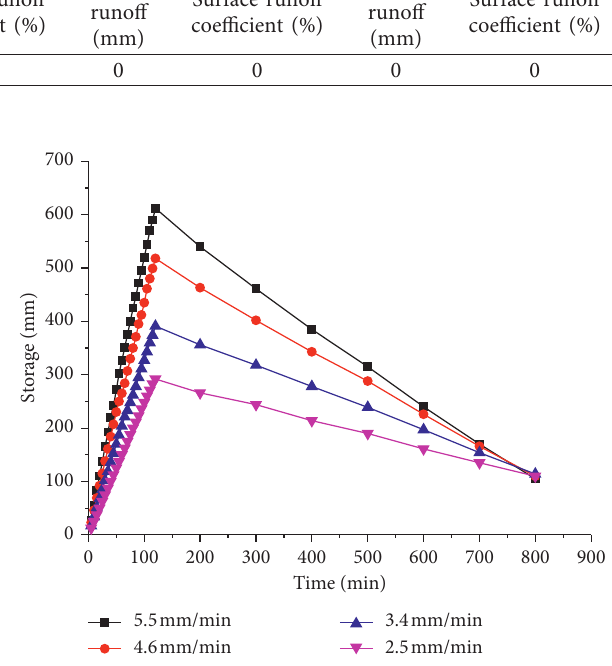
Figure 12: Relationship of storage under different rainfall inten- sities and time.